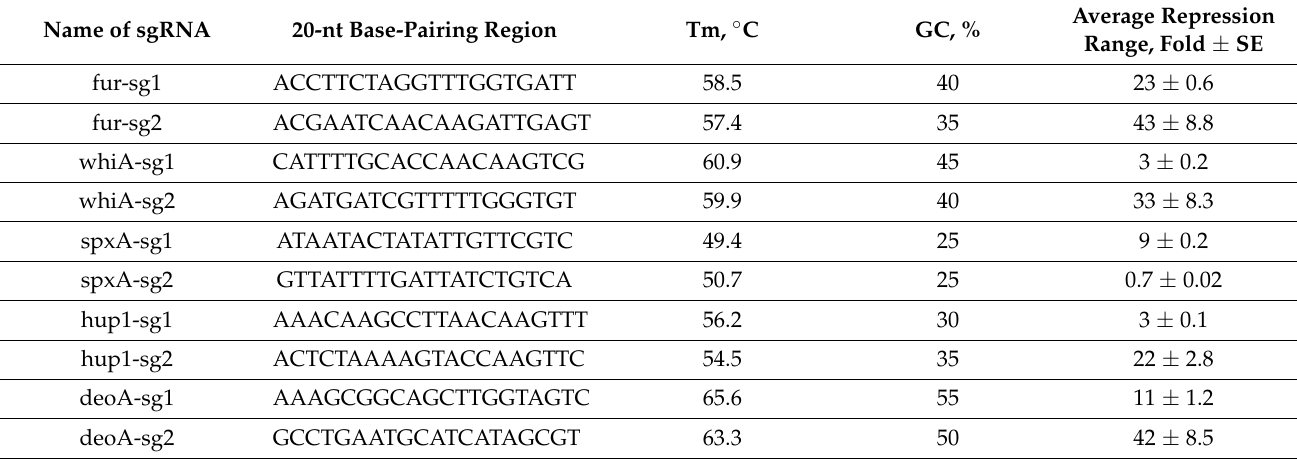
Table 1. Characteristics of designed sgRNAs and their